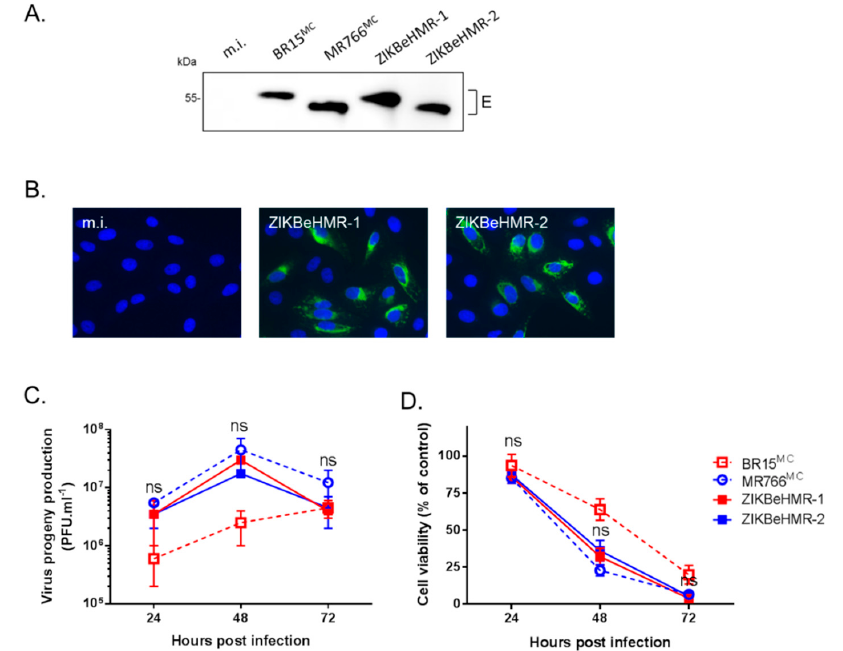
Figure 2. Characterization of ZIKBeHMR-2 replication in Vero cells. Vero cells were infected 24 h with viral clones BR15 MC , MR766 MC , ZIKBeHMR-1 or ZIKBeHMR-2 at m.o.i. of 1. or mock-infected (m.i.). In ( A ), immunoblot assay on RIPA cell lysates using anti-E mAb 4G2. In ( B ), immunofluorescence assay using mAb 4G2. Magnification: 200 × . In ( C ), virus progeny production was determined by plaque-forming assay on Vero cells. Virus titers are presented as the mean ( ± SEM) from three independent experiments. In ( D ), the loss of viability of ZIKV-infected cells was determined using a MTT assay. Viability was expressed as the percentage of cell metabolic activity in ZIKV-infected cells relative to those in mock-infected cells. Data are presented as mean ± SEM of three independent experiments. Statistical significance between ZIKBeHMR-1 and ZIKBeHMR2 values is indicated.